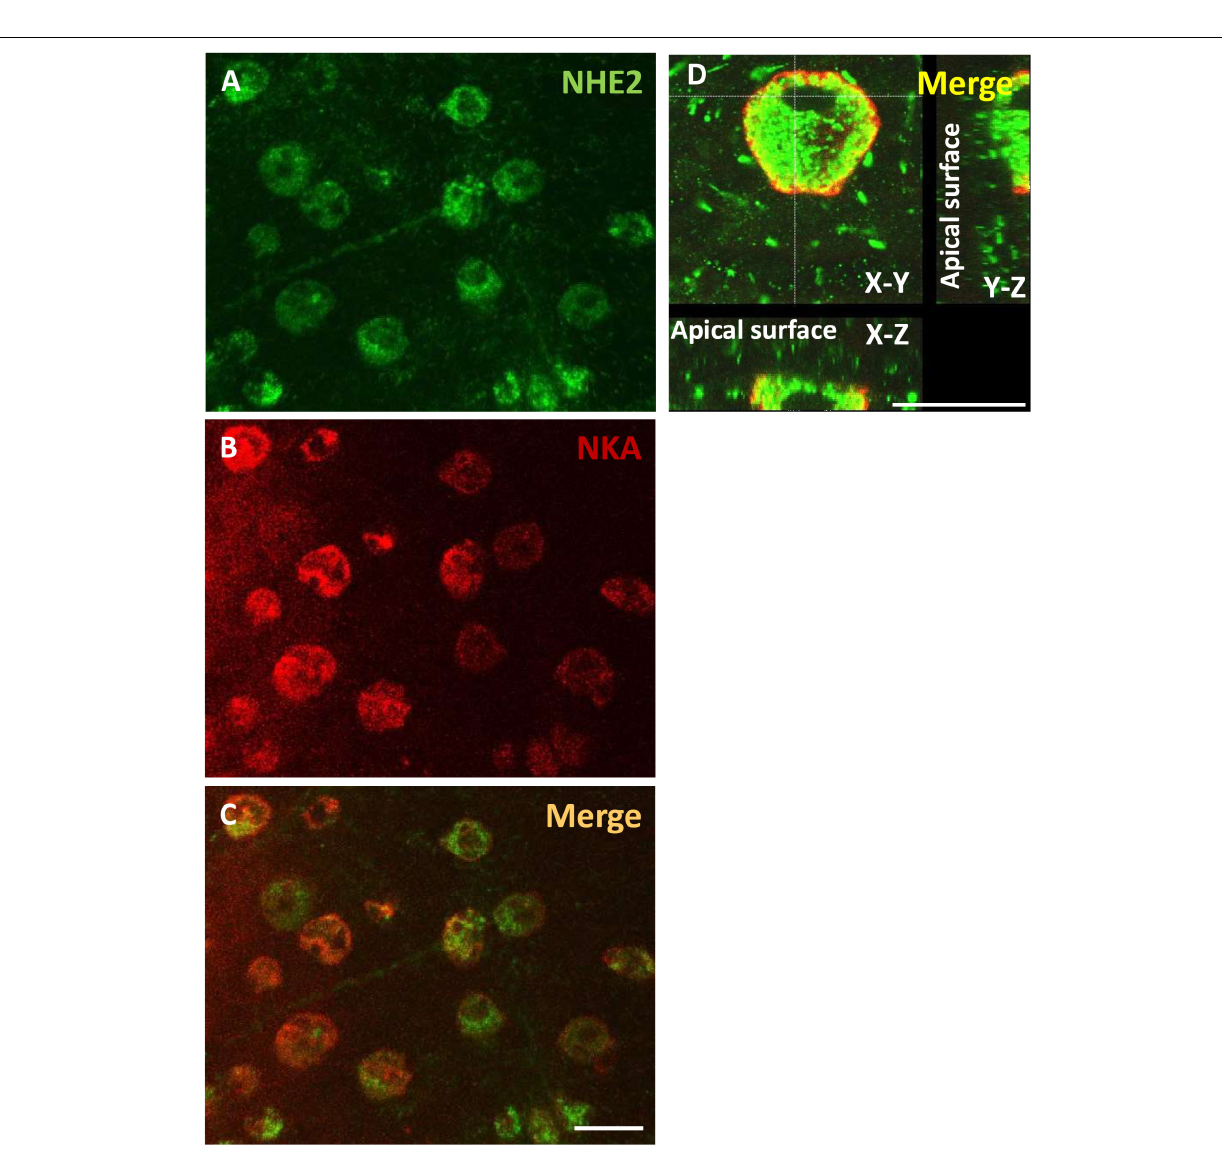
Frontiers in Physiology |